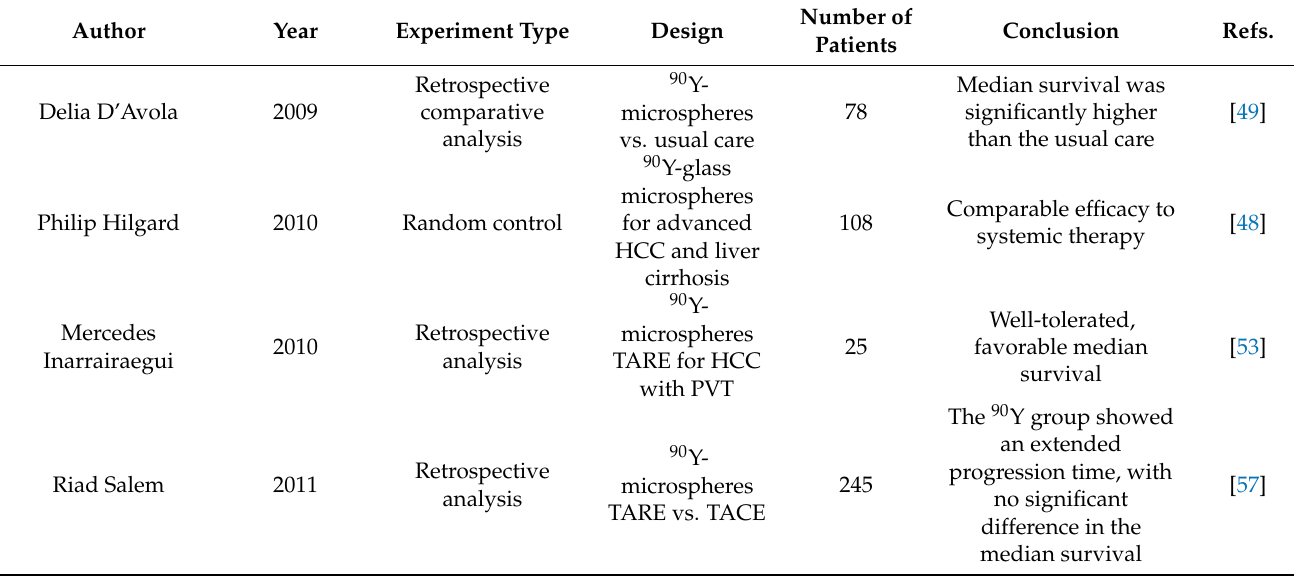
Table 4. Advances for the treatment of HCC with 90 Y-microspheres